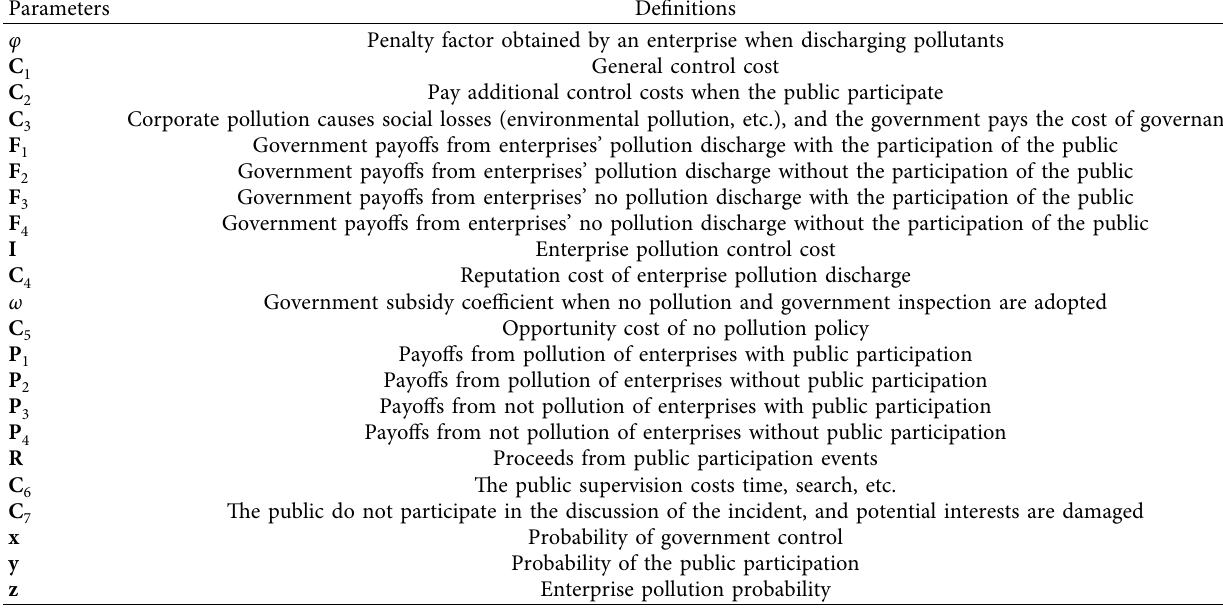
Table 1: Definitions of the parameters.